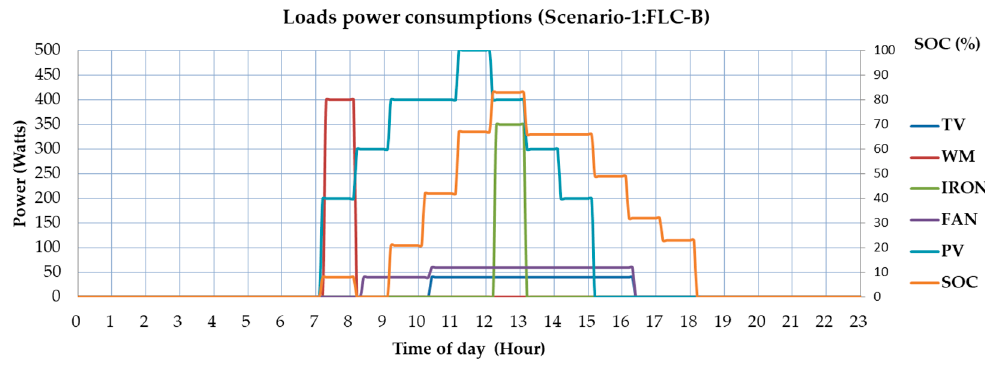
Figure 18. Power consumption of FLC-B in Scenario 1.